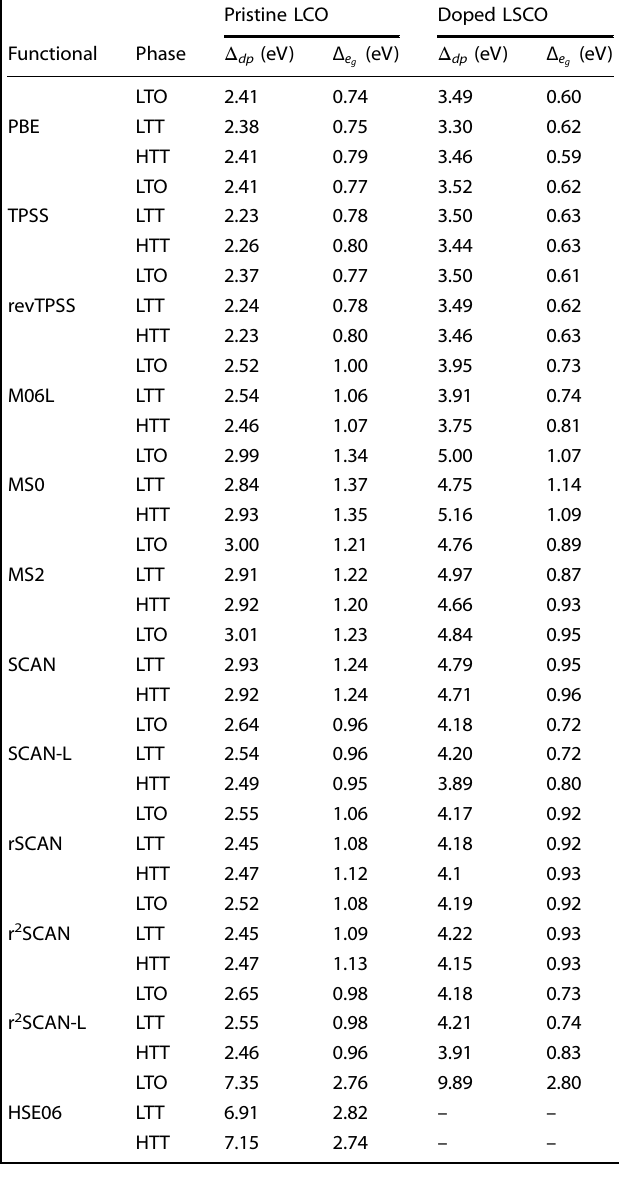
Table 3. Theoretically predicted values of the charge-transfer energies between Cu 3 d and O 2 p orbitals and two Cu energy splitting using various XC functionals for three different phases of pristine LCO and doped LSCO